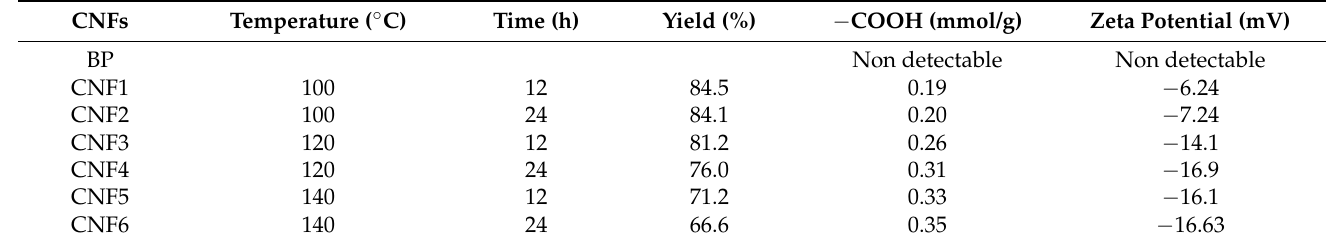
Table 1. Yields, carboxyl group content, and zeta potential of CNF